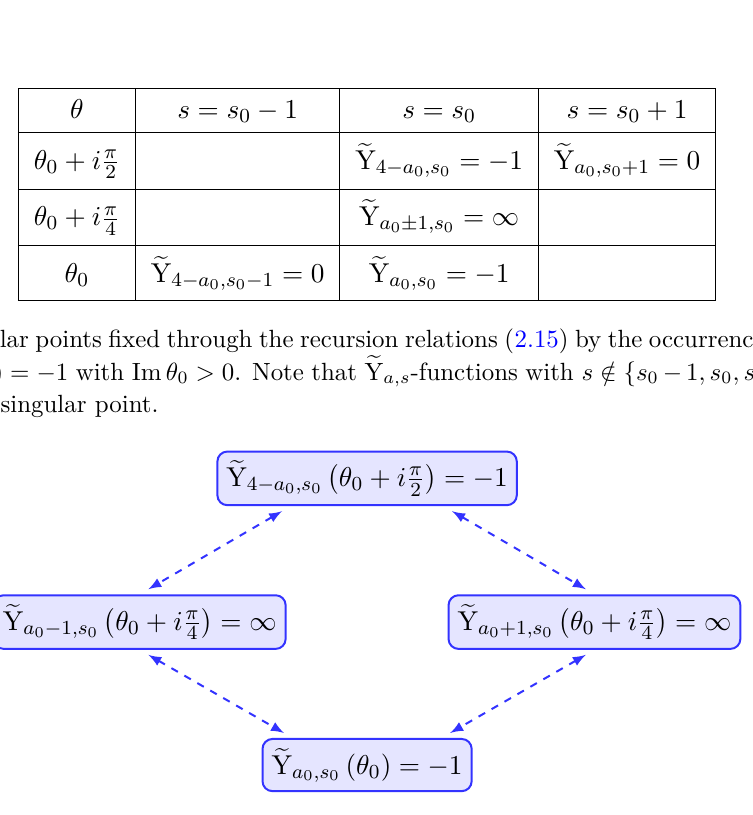
Figure 3 . Related singular points of the Y -system enforced by the recursion relations due to the occurrence of the singular point e Y